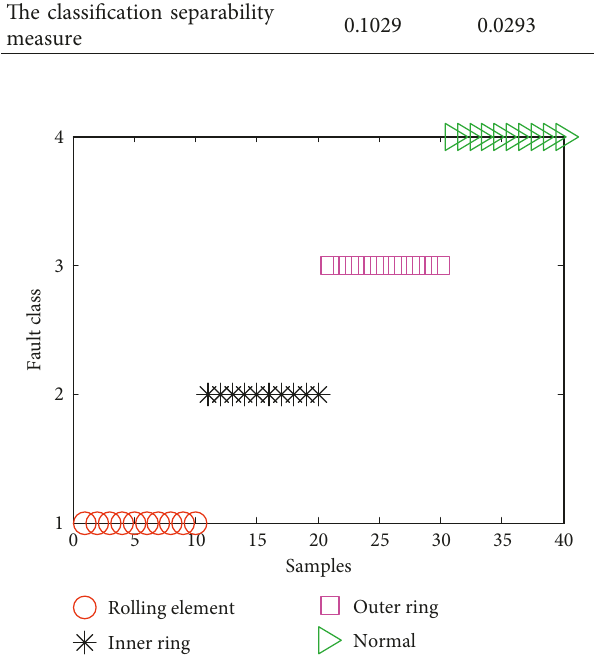
Figure 10: Classification result of bearing.